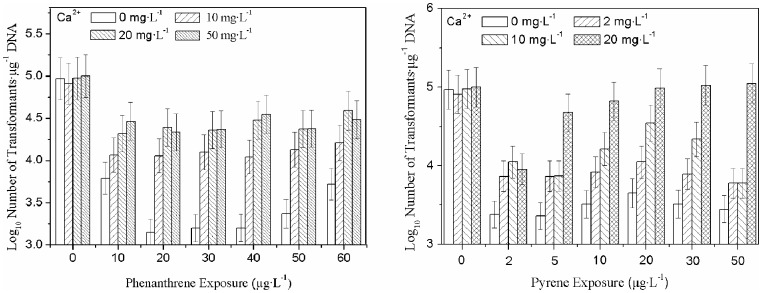
The Ca2+-influenced transformation efficiency of plasmid DNA exposed to phenanthrene (left) and pyrene (right).The transformation efficiency was calculated according to Equation I. Error bars represent 1 standard deviation (n = 3).